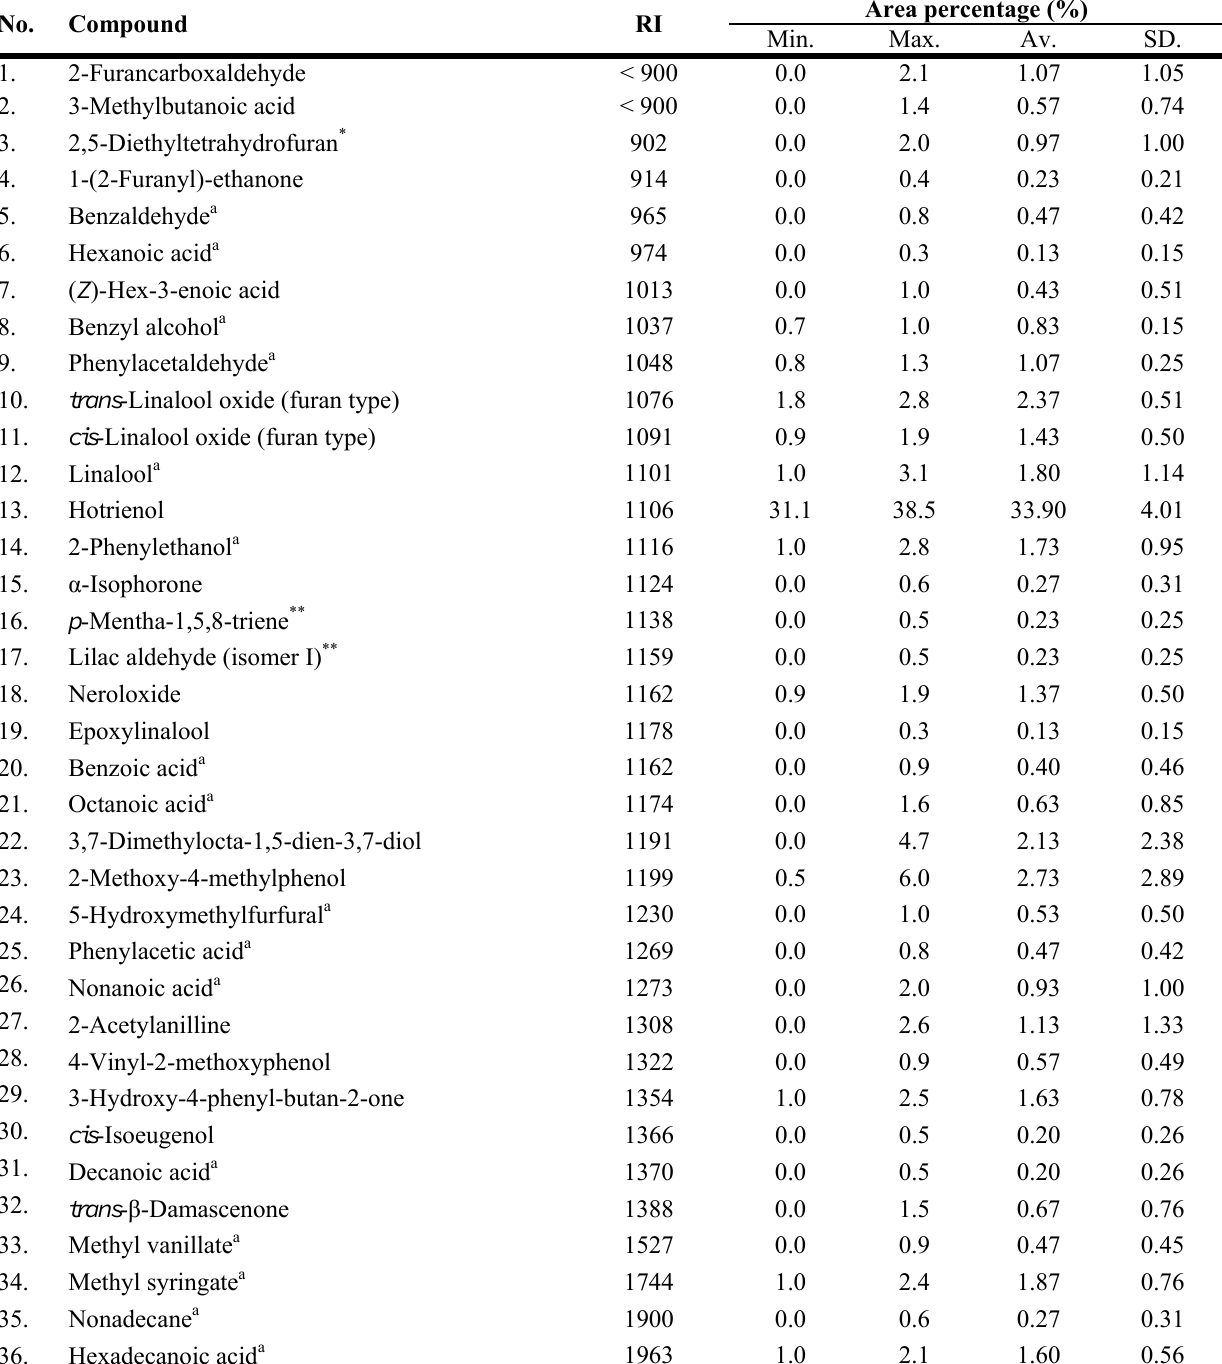
Table 2. Mentha spp. honey solvent-free organic extractives composition isolated by